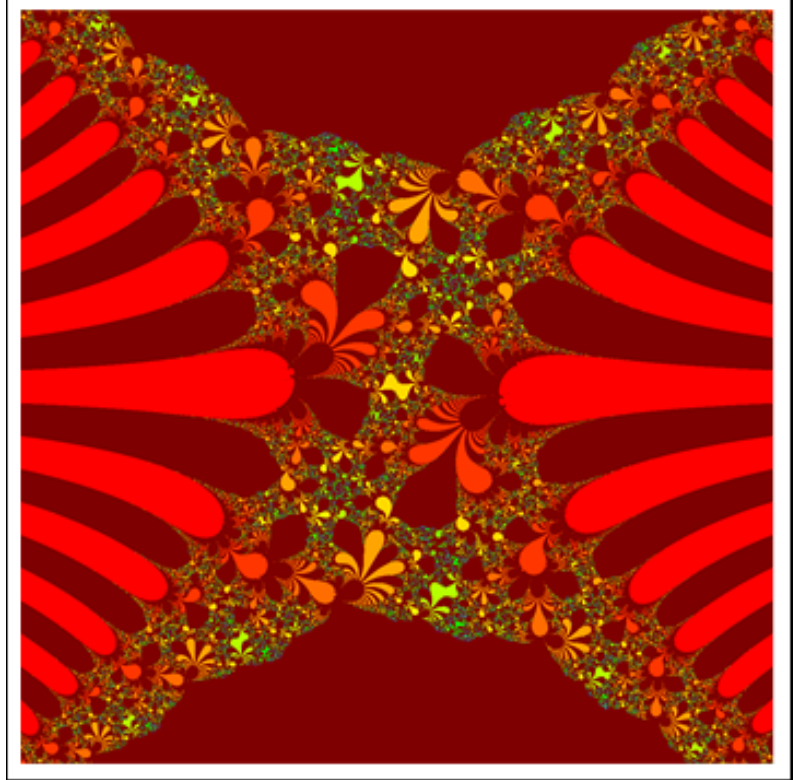
Figure 13. J-set for τ ( z ) = e z 2 + c via DKIS. The image execution time is 389.531